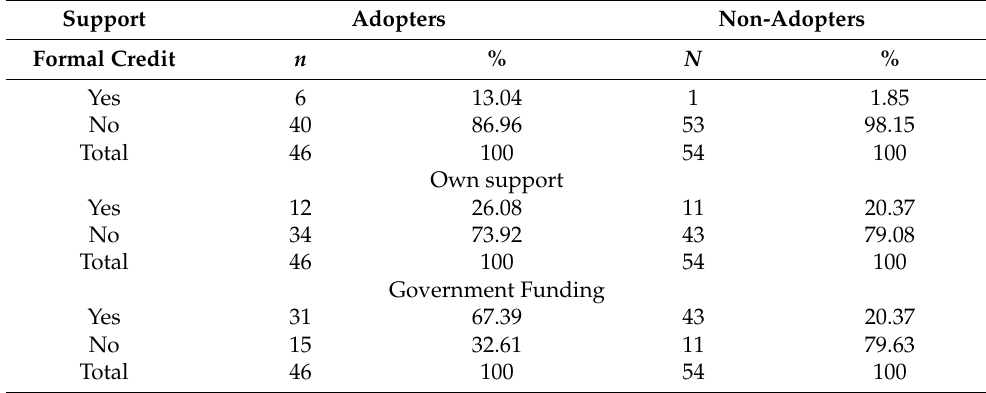
Table 8. Sources of funding used to support SHF in adopting